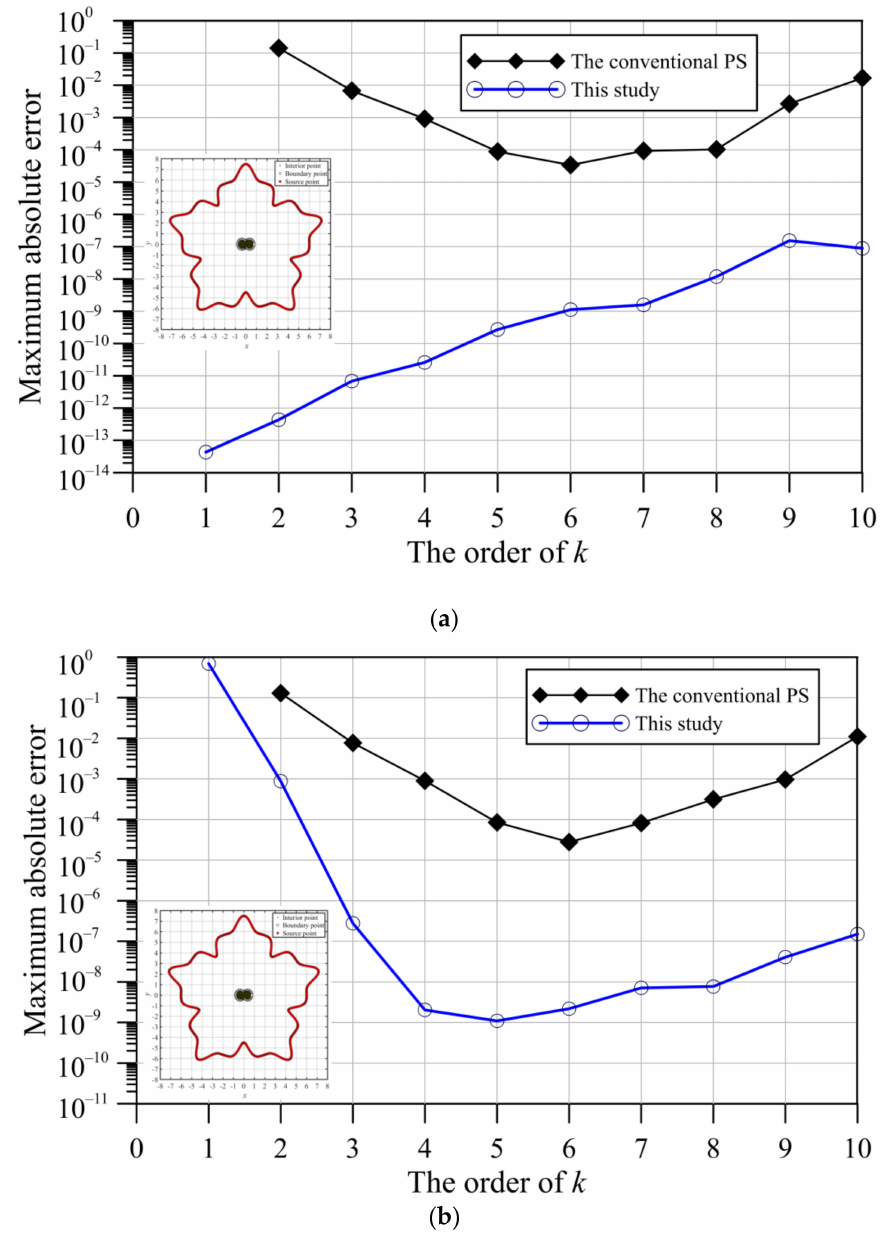
Figure 15. The computed MAE values of the original PRBF and the proposed method: ( a ) α g = 0.0001; ( b ) α g =